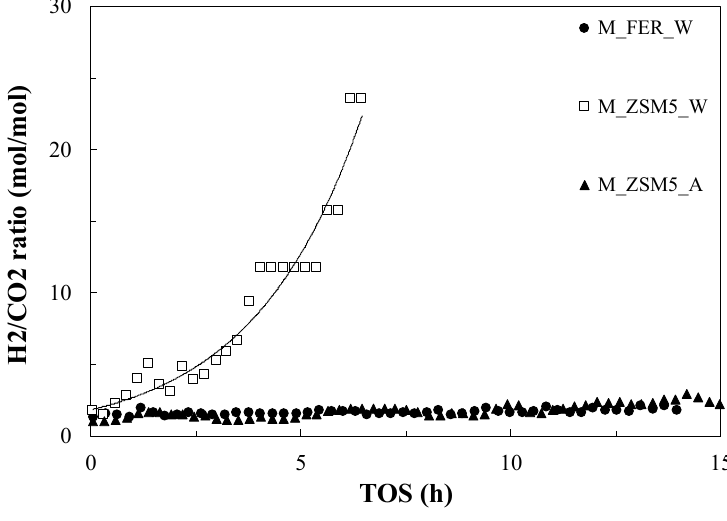
Figure 7. H 2 / CO 2 ratio measured during TOS Figure 7. H 2 /CO 2 ratio measured during TOS test.